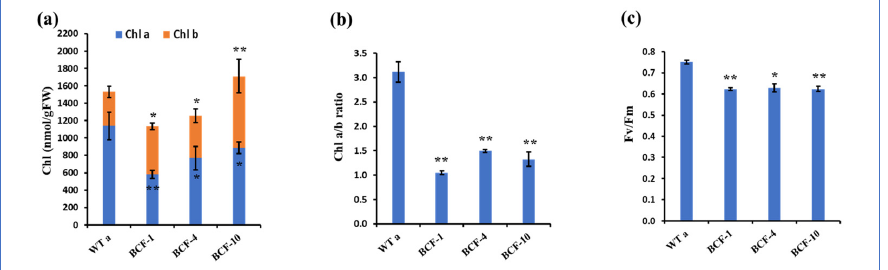
Figure 2. Physiological characteristics of WT and BCF − OE tomato plants. ( a ) Chlorophyll content (Chl a and Chl b ) . ( b ) Chl a/b ratio. ( c ) Fv/Fm of WT and BCF − OE lines. Each data point is the average of five biological replicates (five leaf tissues), and SE represents the standard error. Asterisks indicate a significant difference compared to WT tomato (Student’s t -test, * p < 0.05, ** p <